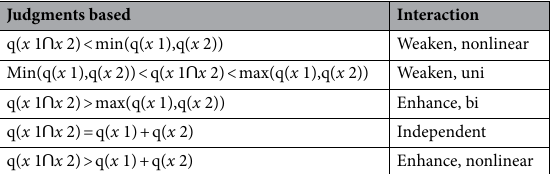
Table 4. Types of interactions between two Covariates to